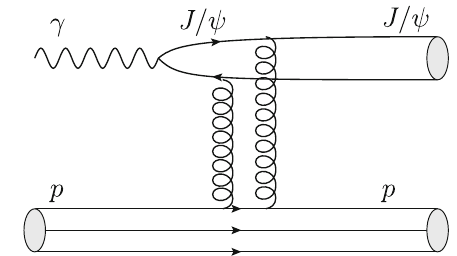
Fig. 1 Vector-meson dominance model mechanism for the near- threshold J /ψ photoproduction